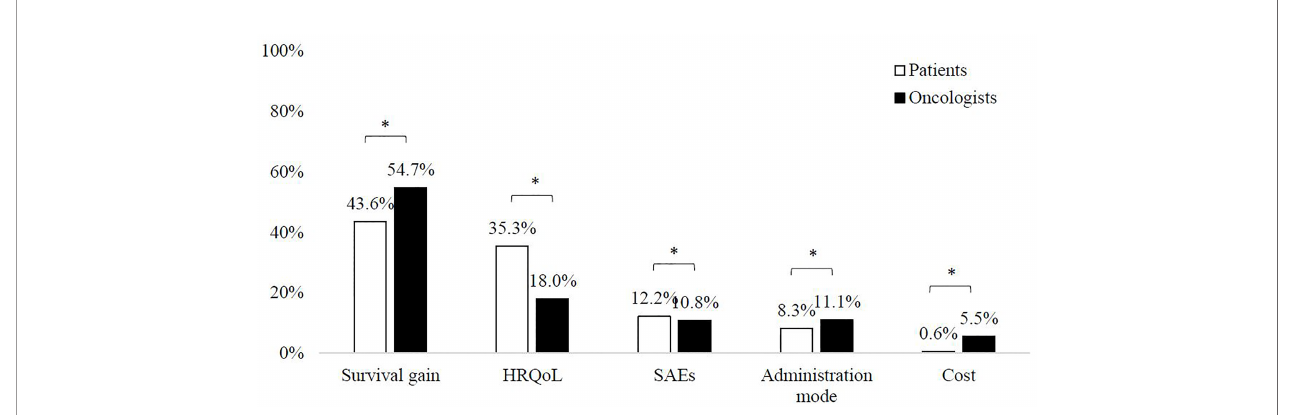
FIGURE 1 | Relative importance of attributes *Signi fi cant difference between patients and oncologists (p <